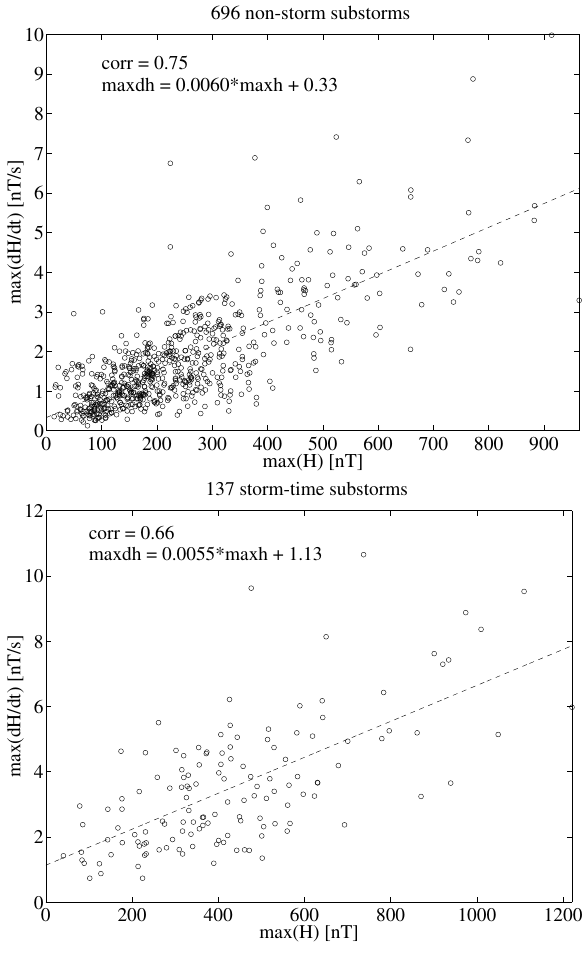
Fig. 7. The max( | d H /dt | ) versus | H | at the maximum times of | d H /dt | during non-storm (upper panel) and storm-time (lower d H /dt j ) versus j H j at the maximum times of j d H /dt j during non-storm (upper Fig. 7. max( j panel) substorms. The dashed line is the linear regression curve. panel) and storm-time (lower panel) substorms. The dashed line is the linear regression curve.